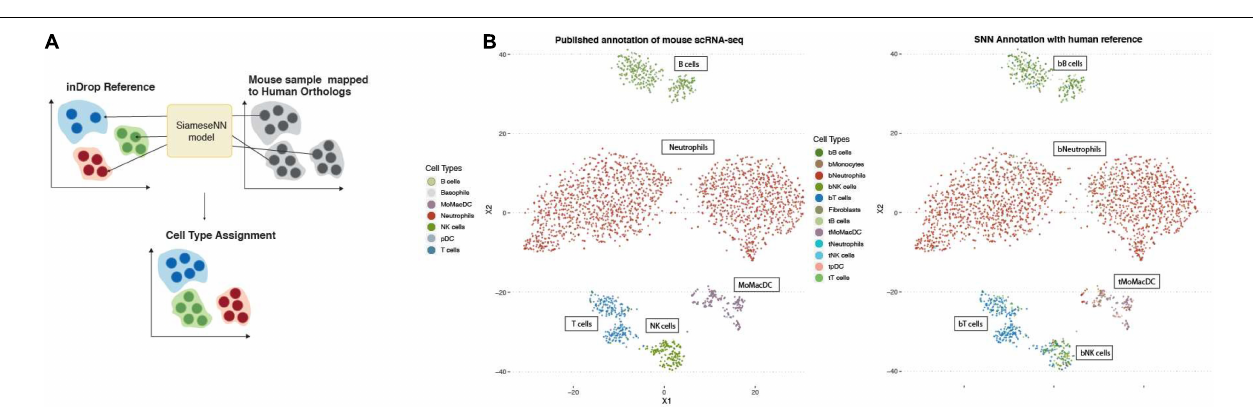
FIGURE 5 | Alluvial plot of a single patient sample annotated using individually trained models derived from other patients and the Human Cell Landscape (HCL) model. Each column reflects the annotation of patient 1 data by various trained models using the SNN architecture. The leftmost column reflects annotations by Siamese Neural Network (SNN)-Human Cell Landscape model. The second column represents the original annotation for patient 1. The remaining columns represents annotations by models trained with different patient data (p2, p4, p5, p6, p7, p8). Cell Types are colored with respect to p1 (ground truth) annotations.